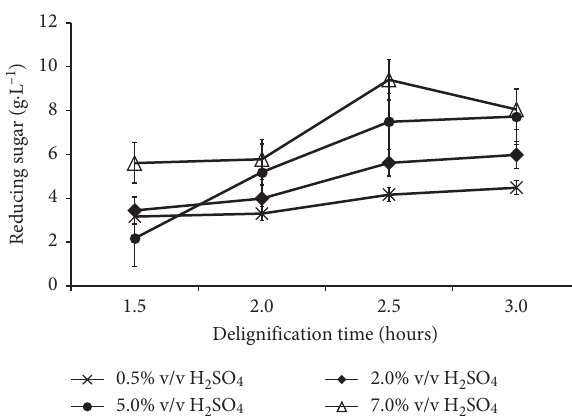
Figure 2: The concentration of the reducing sugar (g/L) produced from alkaline delignification of elephant grass powder followed by acid hydrolysis at various concentrations of sulfuric